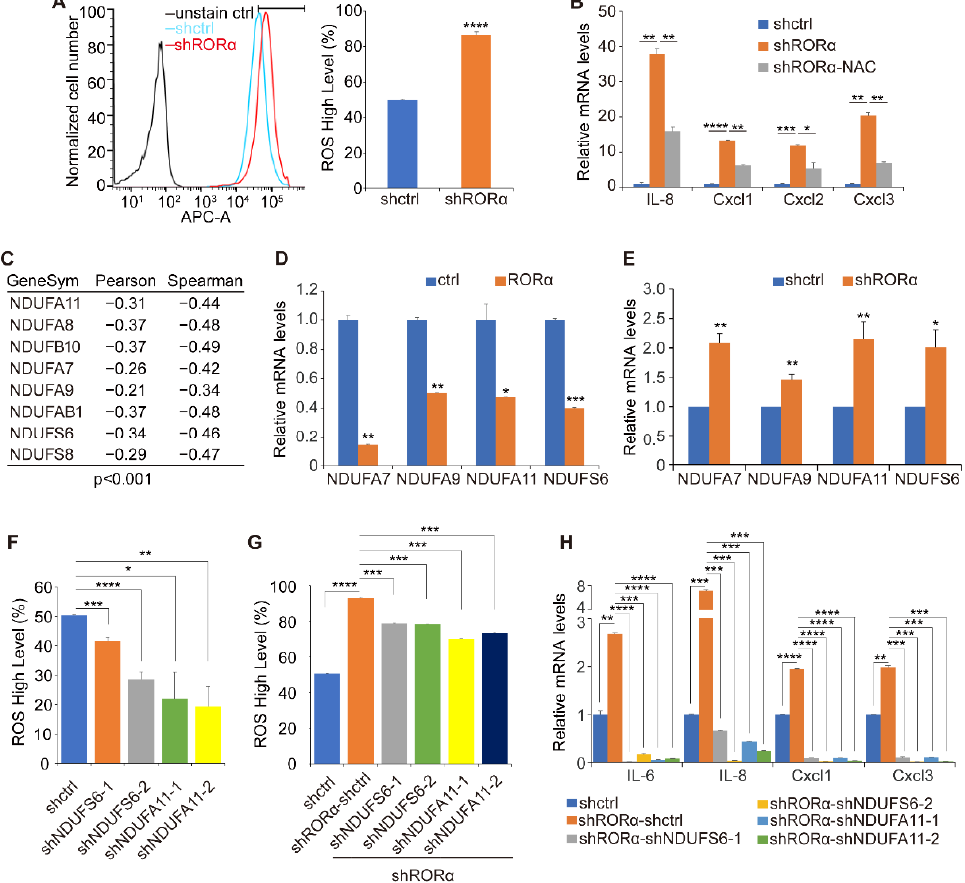
Figure 2. ROS mediates ROR α function in repressing cytokine expression. ( A ) FACS analysis quantified ROS levels in control and ROR α -silenced MCF-10A cells, the top 50% of cell population in control group was gated as “ROS High”; results are presented as mean ± SEM; n = 4, **** p < 0.0001, student’s t-tests. ( B ) Real-time RT-PCR quantified mRNA levels of cytokines genes in ROR α -silenced MCF-10A cells cultured with or without NAC (4 µM) treatment for 48h; results are presented as mean ± SEM; n = 4, **** p < 0.0001, *** p < 0.001, ** p < 0.01, * p < 0.05, one-way ANOVA test. ( C ) Table showing the significantly negative correlation between ROR α and complex I gene mRNA levels in human breast cancer tissue, gene expression data were derived from the TCGA breast can- cer dataset. ( D ) Real-time RT-PCR quantified mRNA levels of mitochondrial complex I genes in control and ROR α -expressing MDA-MB-231 cells; results are presented as mean ± SEM; n = 4, *** p < 0.001, ** p < 0.01, * p < 0.05, student’s t-tests. ( E ) Real-time RT-PCR quantified mRNA levels of mitochondrial complex I genes in control and ROR α -silenced MCF-10A cells; results are presented as mean ± SEM; n =4, ** p < 0.01, * p < 0.05, student’s t-tests. ( F ) FACS quantification of ROS levels in control or NDUFS6-silenced or NDUFA11-silenced MDA-MB-231 cells; results are presented as mean ± SEM; n = 4, **** p < 0.0001, *** p < 0.001, ** p < 0.01, * p < 0.05, one-way ANOVA test. ( G ) FACS quantification of ROS levels in control or ROR α -silenced or ROR α &NDUFS6-silenced or ROR α &NDUFA11-silenced MCF-10A cells; results are presented as mean ± SEM; n = 4, **** p < 0.0001, *** p < 0.001, one-way ANOVA test. ( H ) Real-time RT-PCR quantified mRNA levels of cyto- kines genes; NDUFS6 or NDUFA11 knockdown partially rescued the expression of these genes in ROR α -silenced MCF-10A cells; results are presented as mean ± SEM; n = 4, **** p < 0.0001, *** p < 0.001, ** p < 0.01, one-way ANOVA test. Electron leakage from the respiration chain increases superoxide anion production [27]. To determine whether the ROR α /complex I axis inhibits electron leakage in mito- chondria, we measured superoxide anion levels with mitoSOX red in control and ROR α - expressing breast cancer cells [28]. Silencing ROR α significantly increased mitochondrial